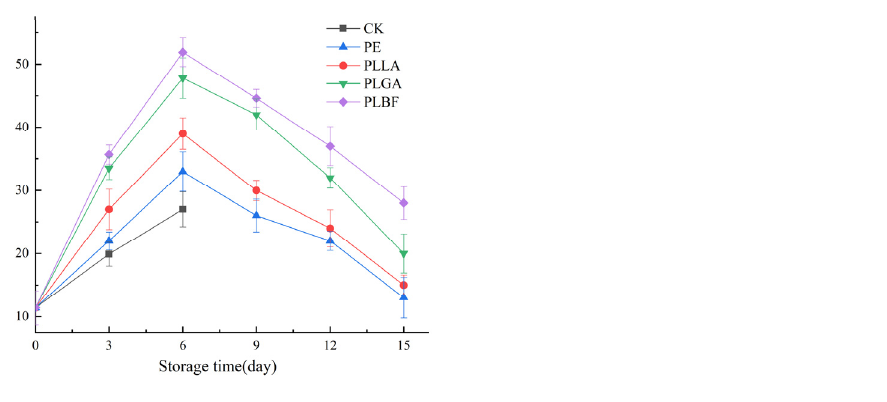
Figure 11. Changes of SOD activity of Agaricus bisporus in each packing group during storage.